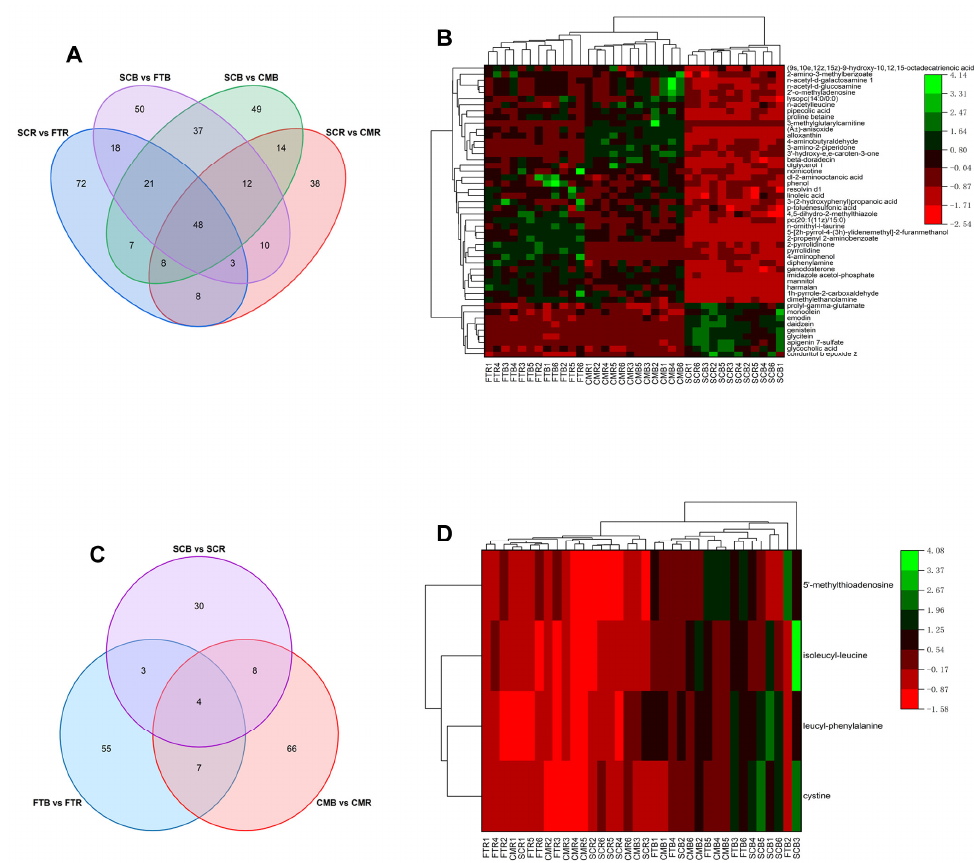
Figure 4. ( A ) Venn diagram showing numbers of differential metabolites involved in domestication based on paired comparisons of SCR vs. FTR, SCR vs. CMR, SCB vs. FTB, and SCB vs. CMB datasets. ( B ) Changes in patterns of the differential metabolites induced by domestication visualized in a heatmap with HCA. ( C ) Venn diagram showing numbers of differential metabolites induced by boiling based on paired comparisons of FTB vs. FTR, CMB vs. CMR, and SCB vs. SCR datasets. ( D ) HCA of the overlapping differential metabolites identified in three pairwise comparisons between boiled and raw egg yolk samples.